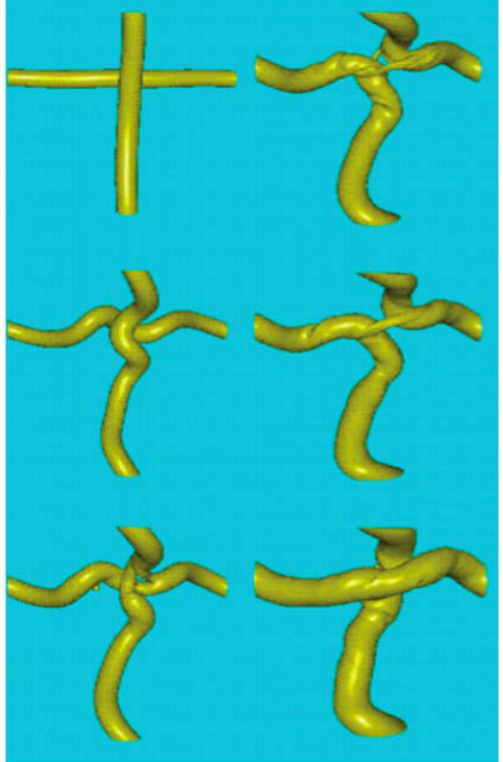
Figure 21. CRUNCH 3D compressible MHD simulation of fluxtube tunneling. Note that fluxtubes pass through each other as multiple field line reconnections occur.